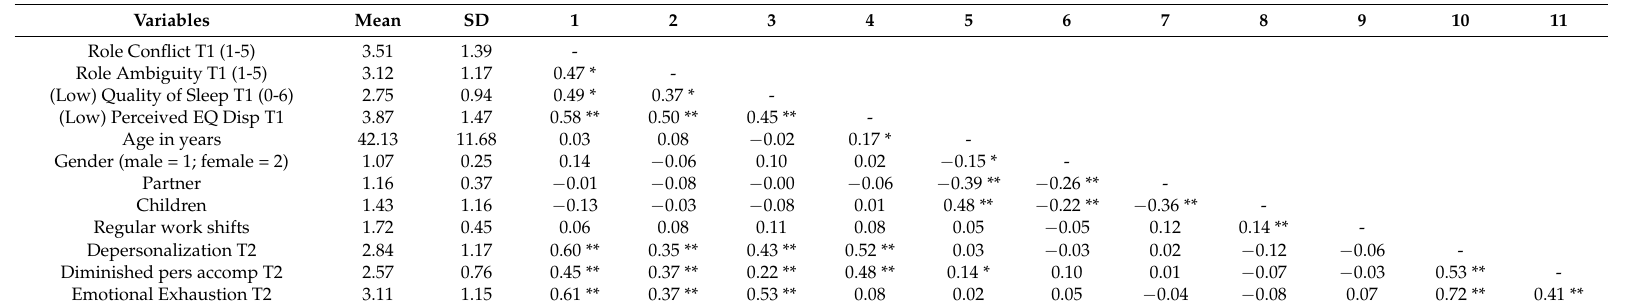
Table 1. Means, Standard Deviations, and Correlations for all variables in the study (N = 214).